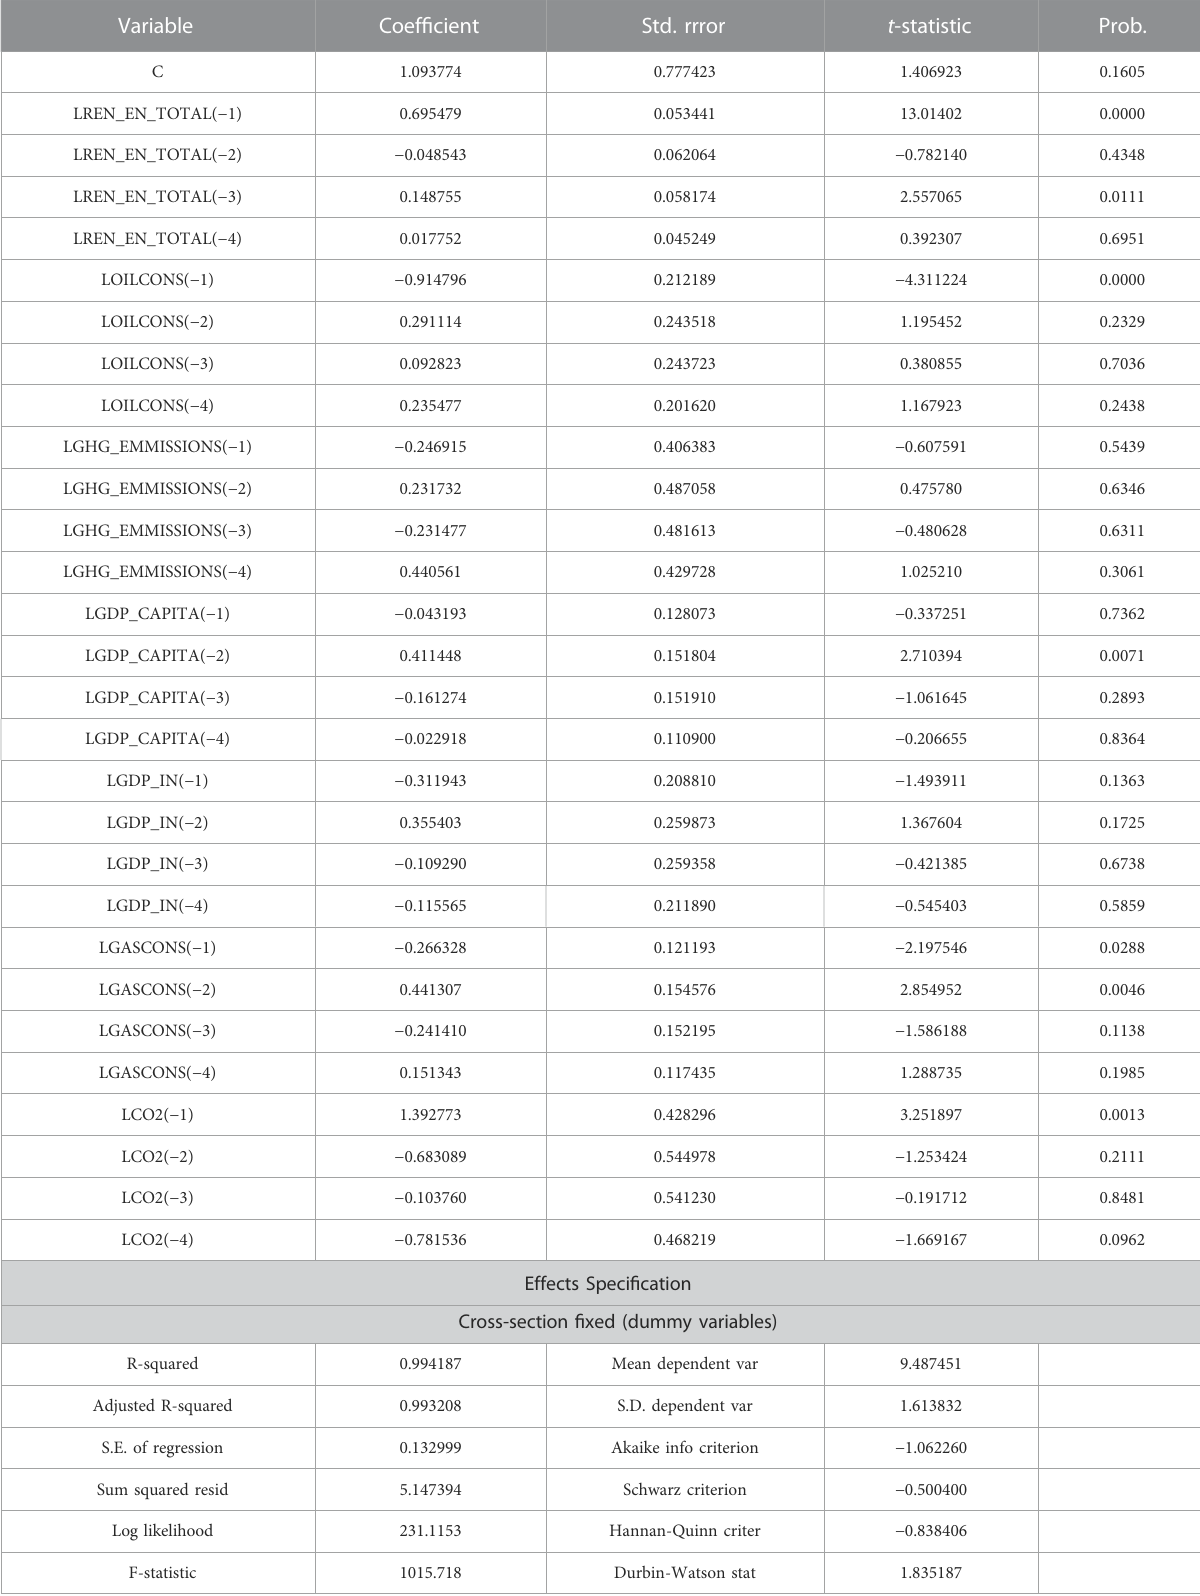
TABLE 8 Panel data analysis by using panel least squares and renewable energy production capacity as dependent variable for